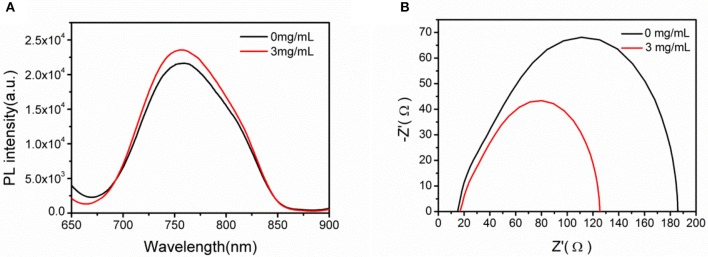
(A) PL spectra measured for device with a geometry of ITO/ETL(40 nm)/PTB7 (50 nm)/MoO3 (5 nm)/Al(10 nm) under photoexcitation of 600 nm at room temperature. (B) Impedance spectra (the Nyquist plot) of the devices with a structure of ITO/ETL(40 nm)/PTB7:PC71BM (95 nm)/MoO3 (5 nm)/Al (80 nm).